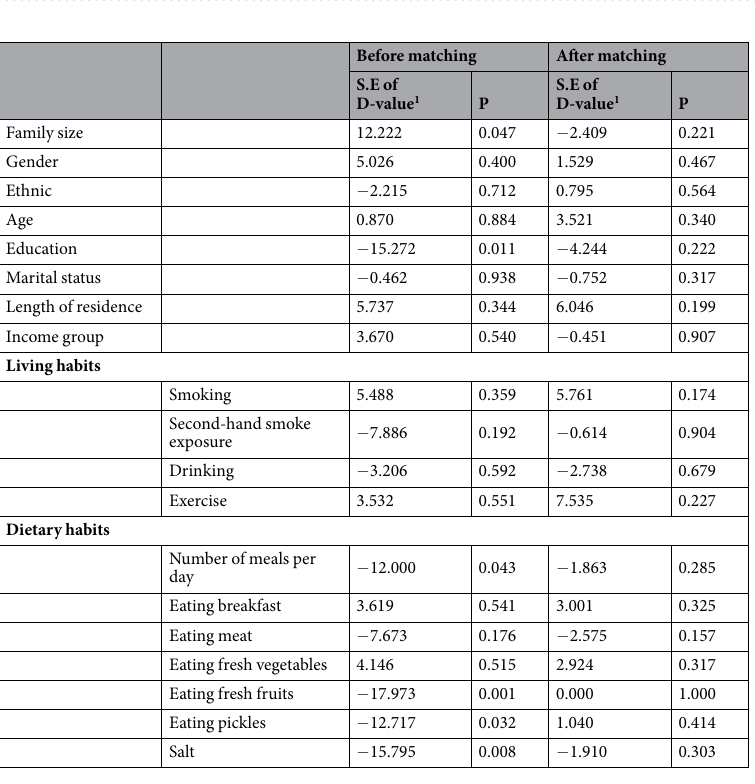
Table 2. Equilibrium test results before and after covariate matching. 1. S.E of D-value means standard error of difference value between high and low exposure